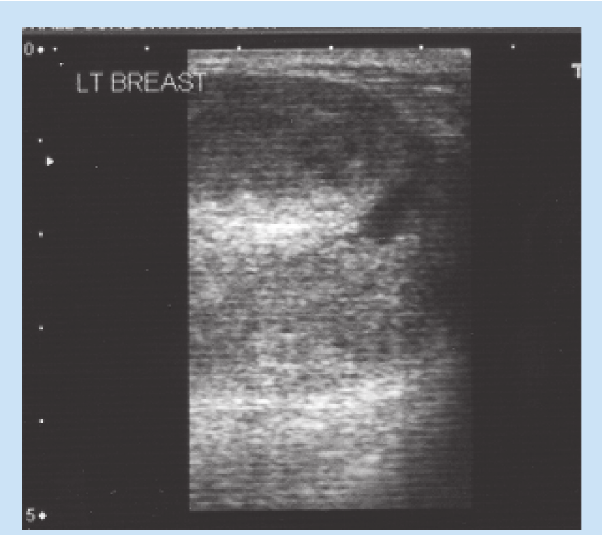
Fig. 1a. Case 1: High-frequency linear ultrasound left breast mass – transverse section.